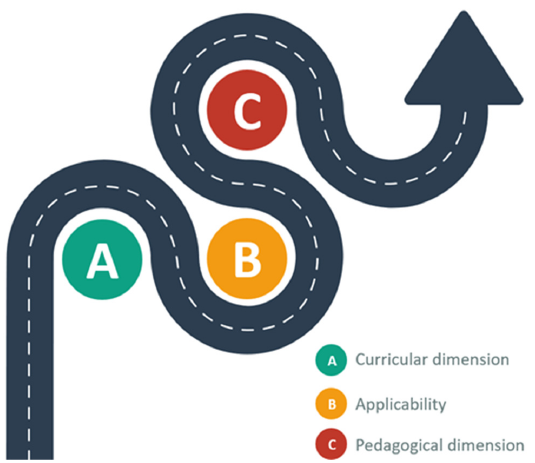
Figure 4. Main categories of statistic education in Colombia.